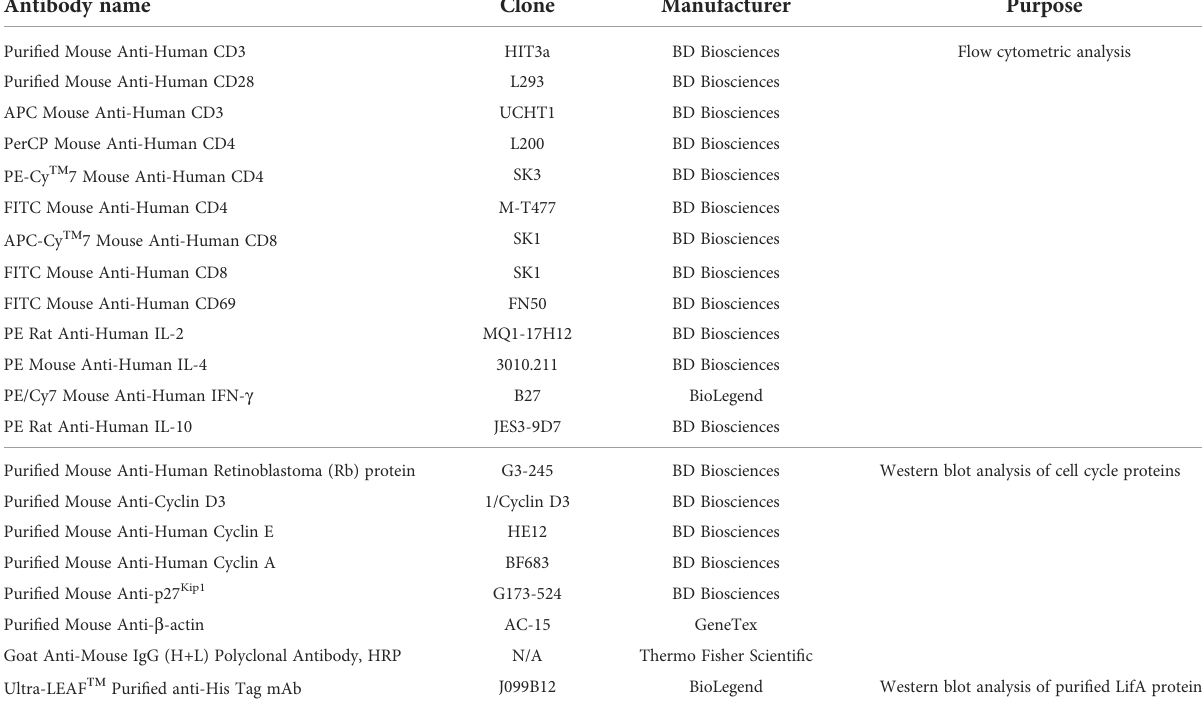
TABLE 1 Antibodies used in this